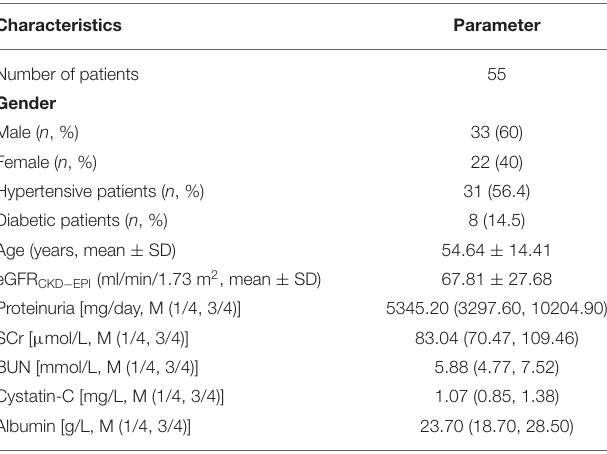
TABLE 1 | Patients’ characteristics. TABLE 2 | The pathological